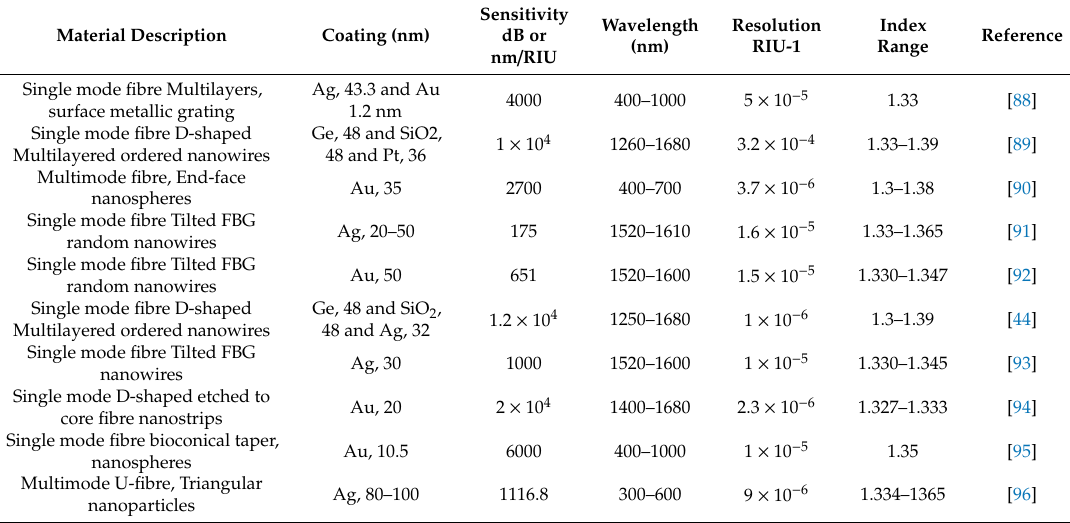
Table 5. Summary of various nanostructured and localised plasmonic